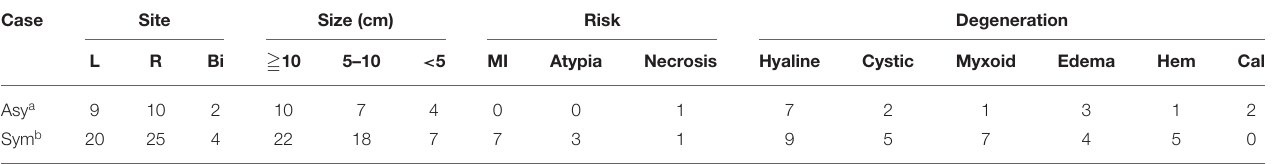
TABLE 7 | Tumor site, size, and histopathological results of patients diagnosed with ovarian leiomyomas.